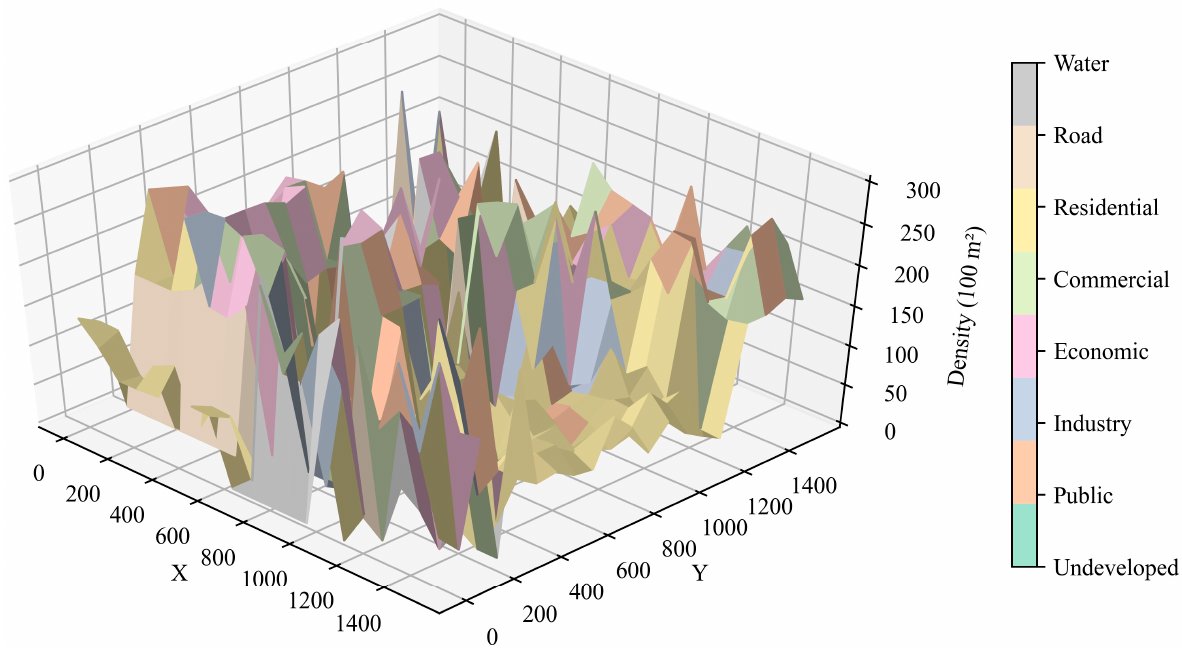
Figure 8. Optimized land use density of the station catchment.